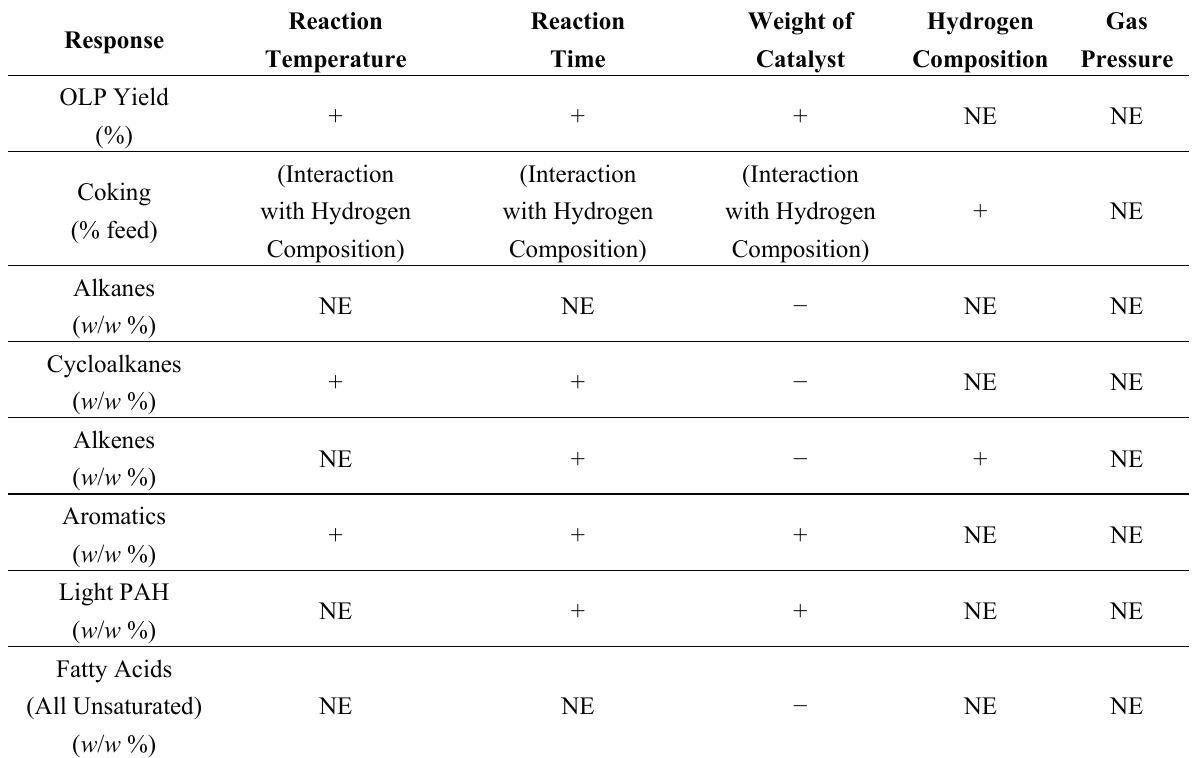
Table 2. A summary of the significant DOE factors in the catalytic cracking of soybean